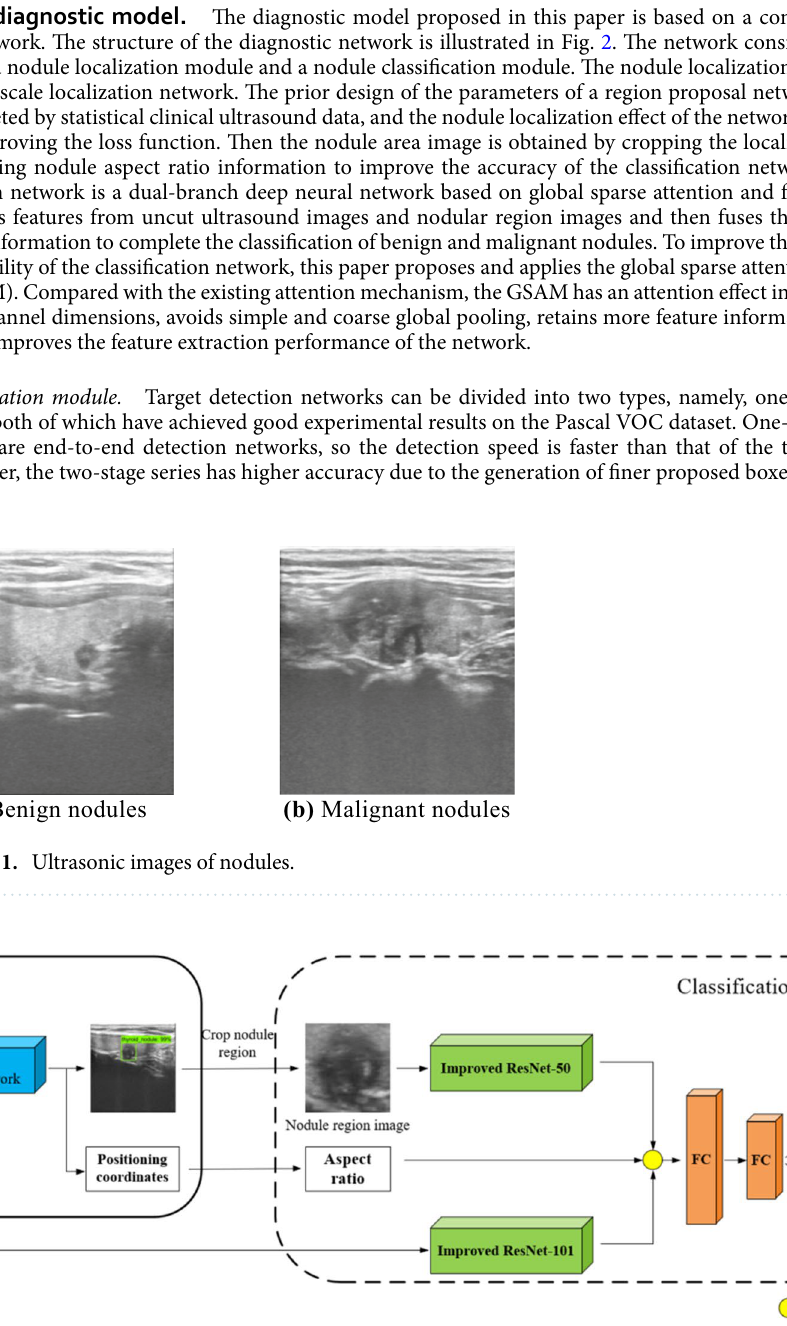
Figure 2. Ultrasound diagnosis network structure for thyroid